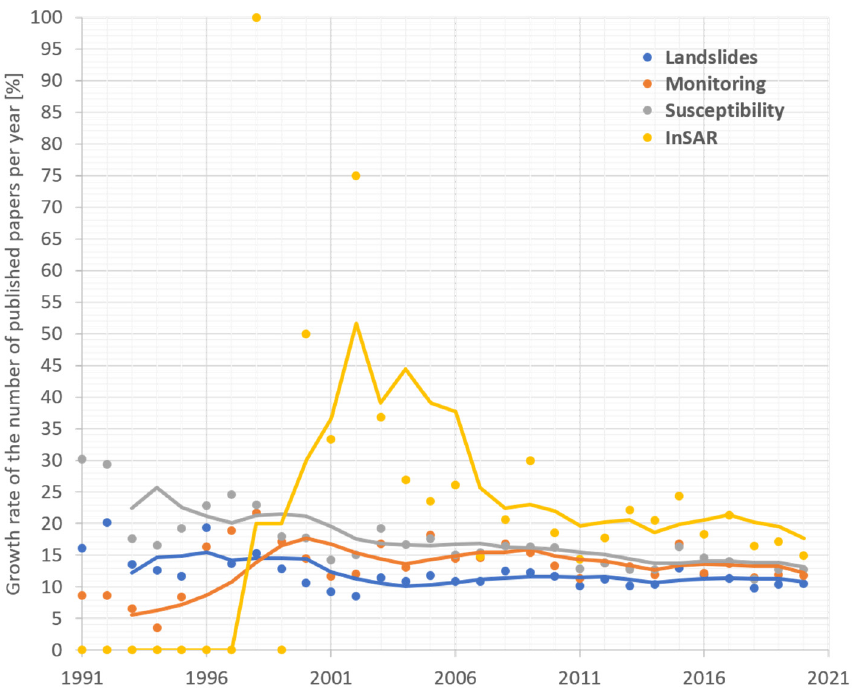
Figure 2. Growth rate of the number of published papers per year on the selected topics since 1990. Lines show the five-year moving average.